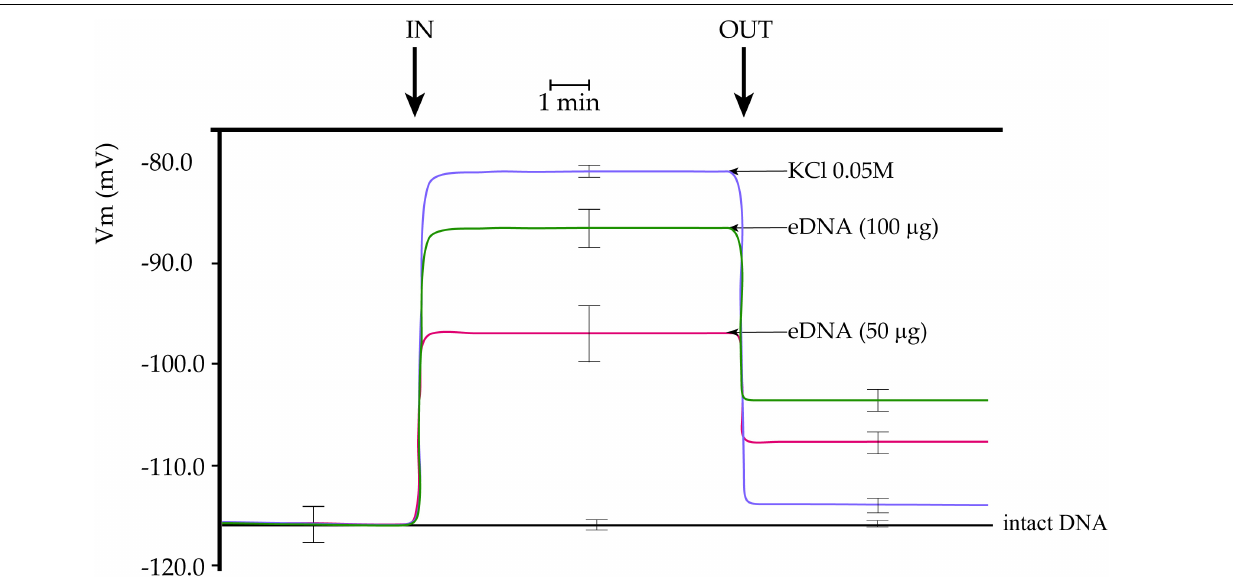
FIGURE 1 | Plasma membrane potential (Vm) depolarization in response to different concentrations of tomato fragmented self-DNA (eDNA) on tomato leaves. No effect on Vm was found after non-fragmented self-DNA (intact DNA) application. 0.05 M KCl caused an expected and almost completely reversible Vm depolarization. Vm depolarization was dependent on eDNA concentration. Washing eDNA treated leaves with fresh buffer was unable to recover the tomato leaf Vm completely. A time scale is indicated. Error bars represent SE ( n = 8–10). IN, timepoint when tomato cells were perfused with either KCl, eDNA, or intact DNA; OUT, timepoint when fresh buffer was perfused to wash out